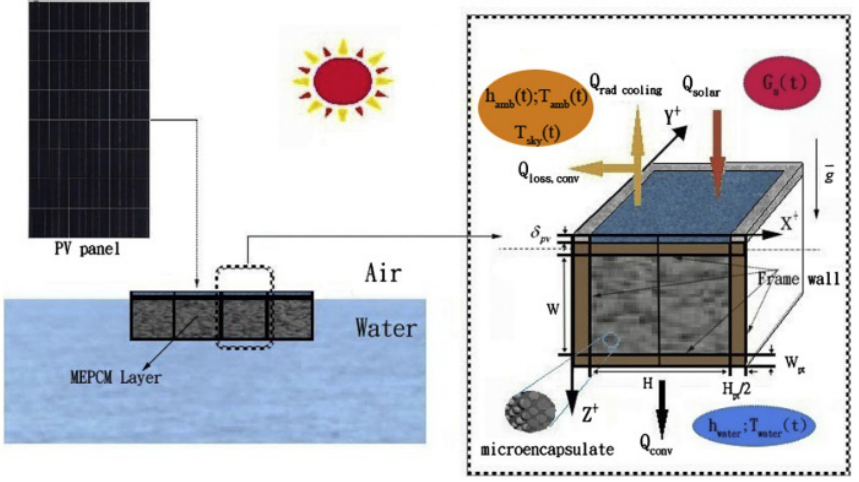
Figure 6. Diagram of the hybrid PVT/PCM system presented by Ho et al. [26]. Adapted with permission from Elsevier.